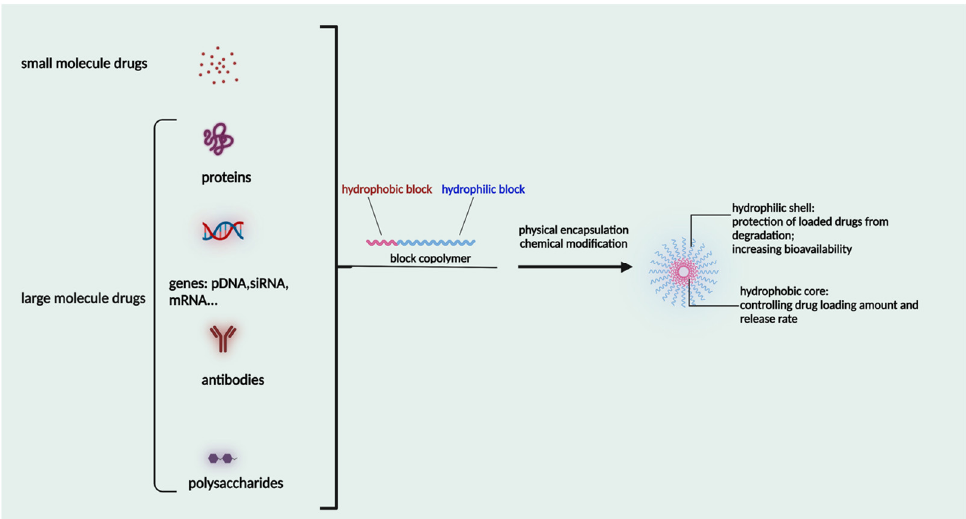
Figure 1. Structure of polymeric micelles for loading small and large molecule drugs. Created with BioRender.com.